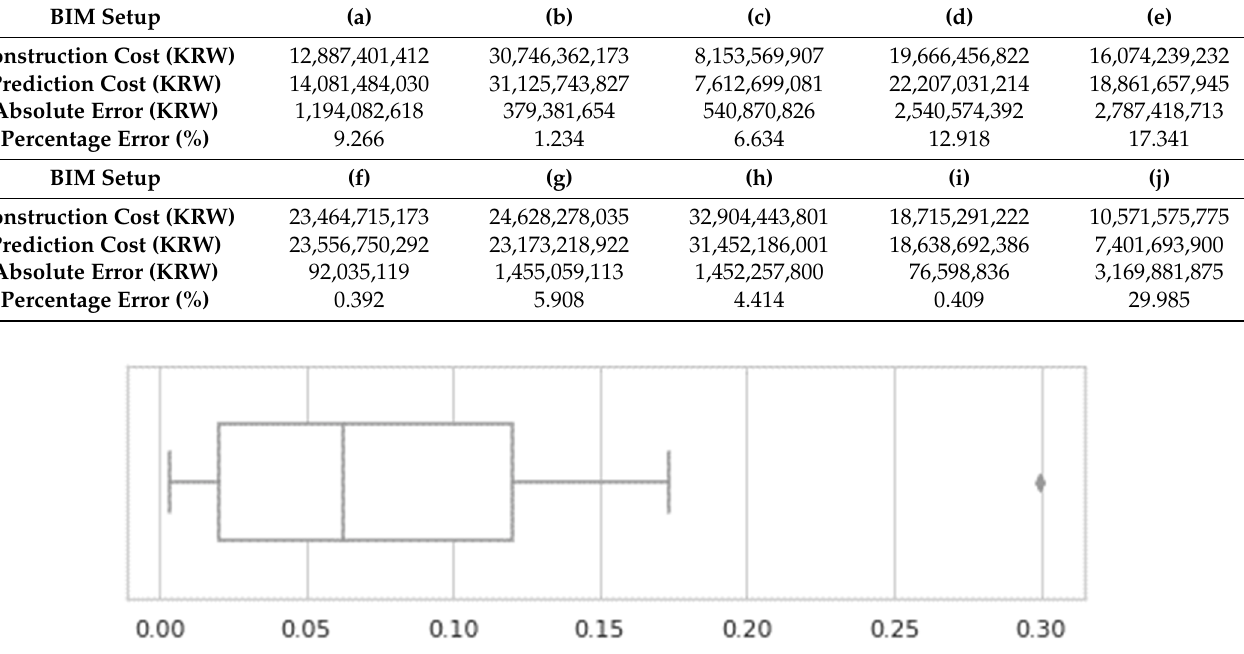
Figure 11. Distribution of percentage error.